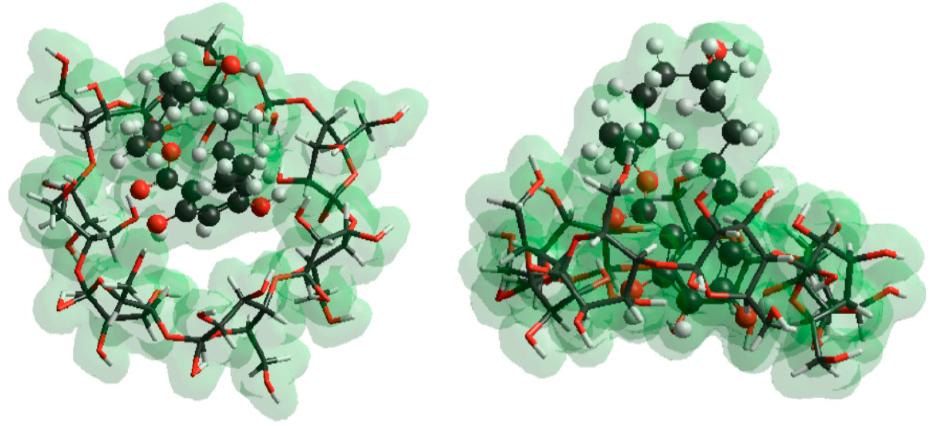
Figure 7. Top and side views of BCD– α -ZOL complex. Aromatic moiety of ZOL molecules is preferred for inclusion interaction with BCD cavity. Table 5. Activation energies associated with the formation of ZOL-CD complexes (based on modeling studies).